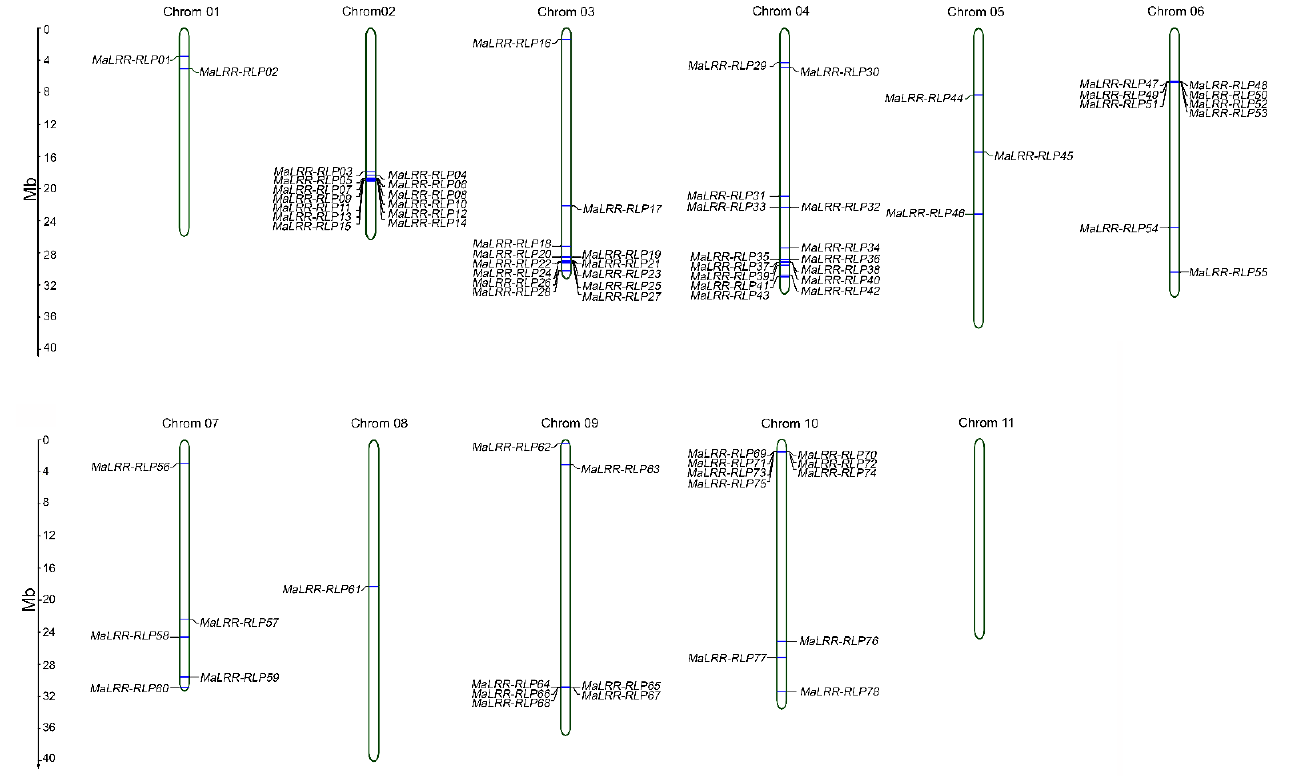
Figure 3. Chromosomal distribution of banana LRR-RLP genes. The chromosome number is shown above each chromosome. The left scale represents the length of chromosomes in megabases. above each chromosome. The left scale represents the length of chromosomes in